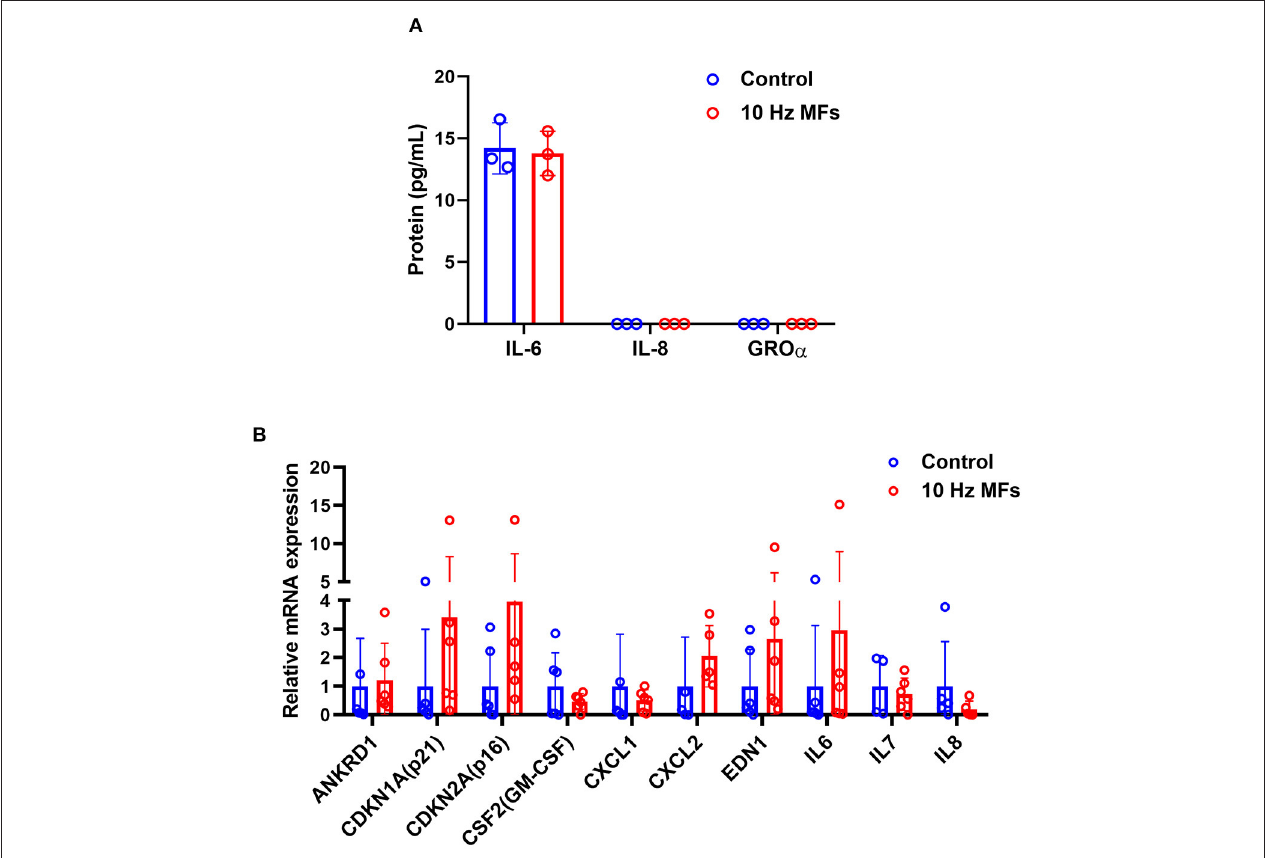
FIGURE 3 | The effect of 10Hz pulsed MFs exposure on SASP in 2BS cells. (A) The levels of IL-6, IL-8, and GRO α in the culture medium and (B) mRNA expression of ANKRD1, CDKN1A, CDKN2A, CSF2, CXCL1, CXCL2, EDN1, IL-6, IL-7, and IL-8 in 2BS cells of control and 10Hz pulsed MFs exposure group. Data were presented as mean ± SD. SASP, senescence-associated secretory phenotype. IL-8, CXC chemokine ligand 8; IL-6, interleukin 6; GRO- α , growth-regulated oncogene